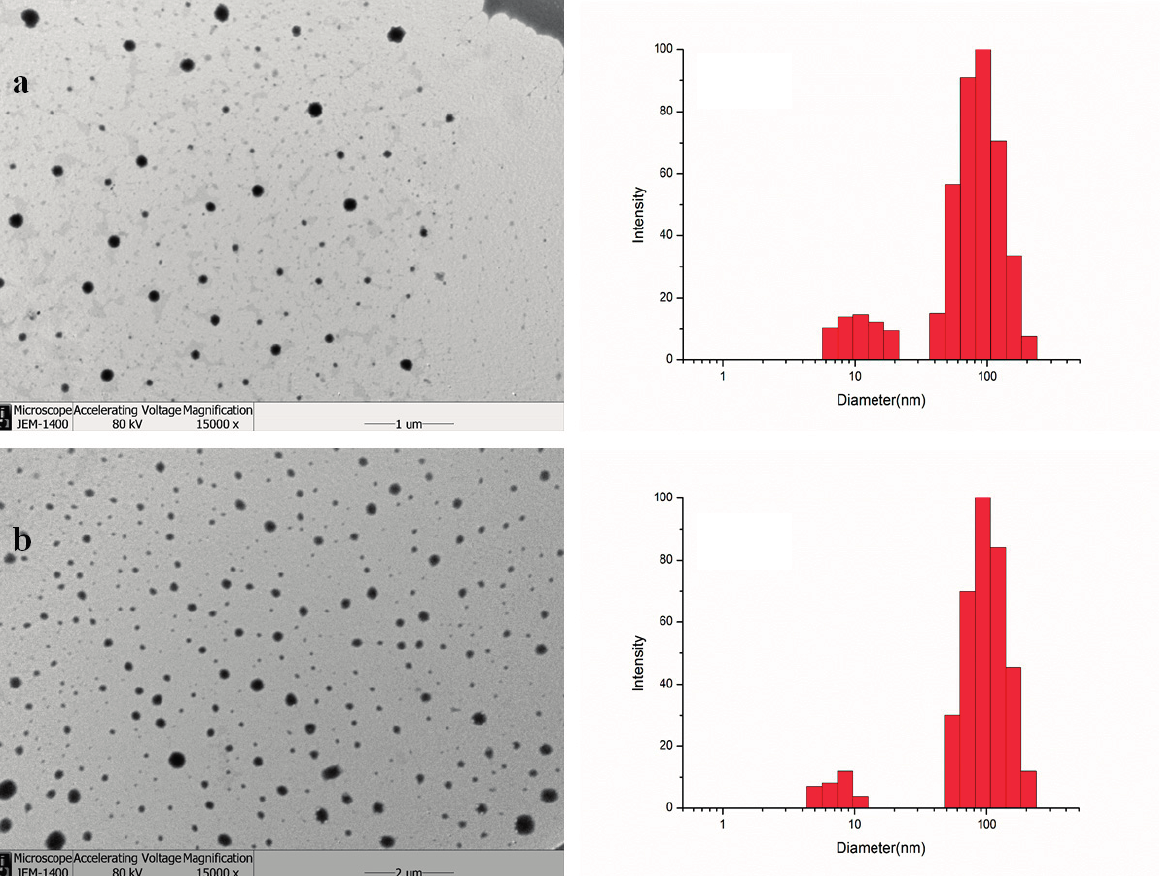
Figure 3. Transmission electron microscopy and size distribution of ( a ) GAP NPs and ( b ) CUR-GAP